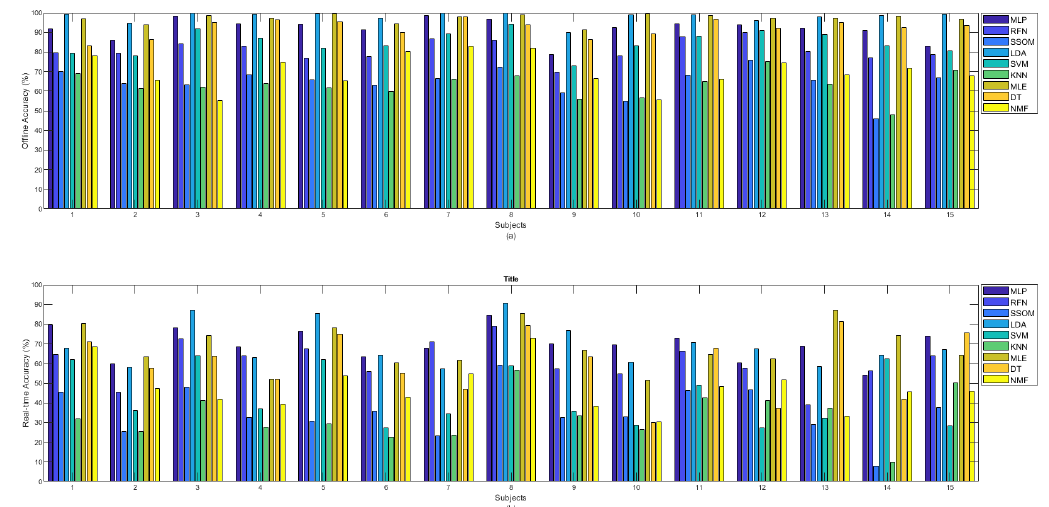
Figure 5. ( a ) Offline and ( b ) real-time accuracies between classifiers per subjects.